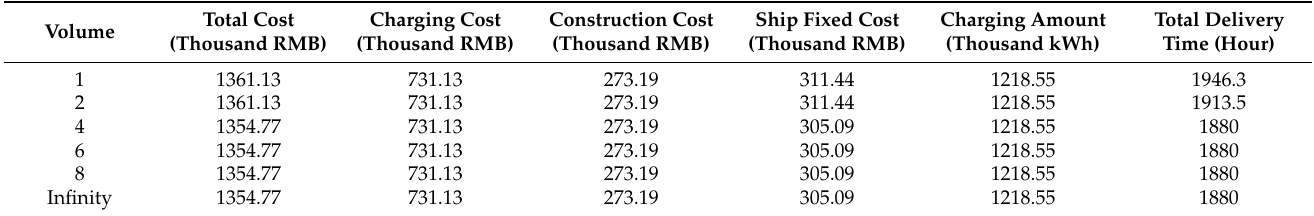
Table 11. Impact of volume